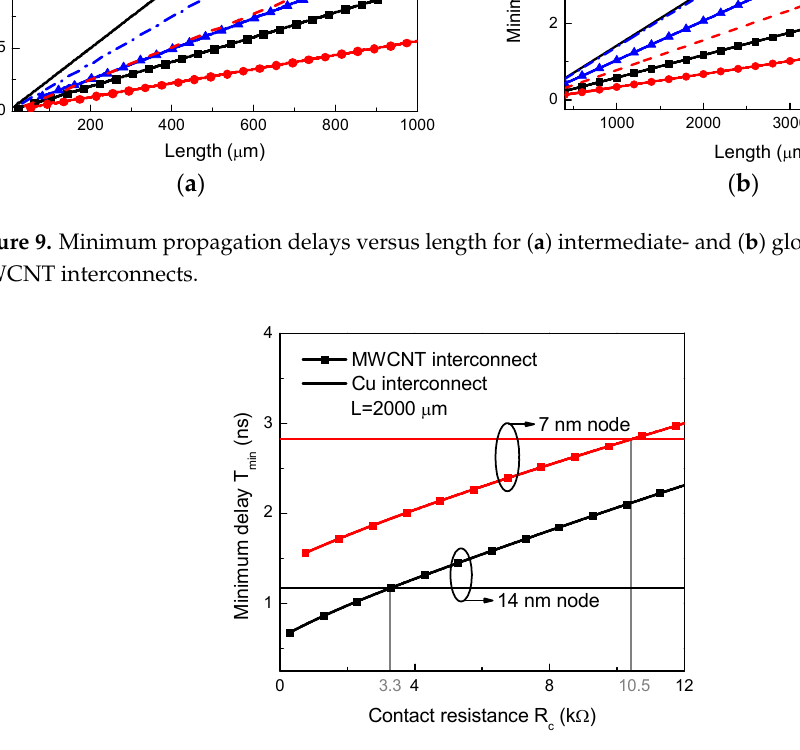
Figure 10. Minimum propagation delay versus contact resistance for 2000- µ m-long global-level Cu and MWCNT interconnects.